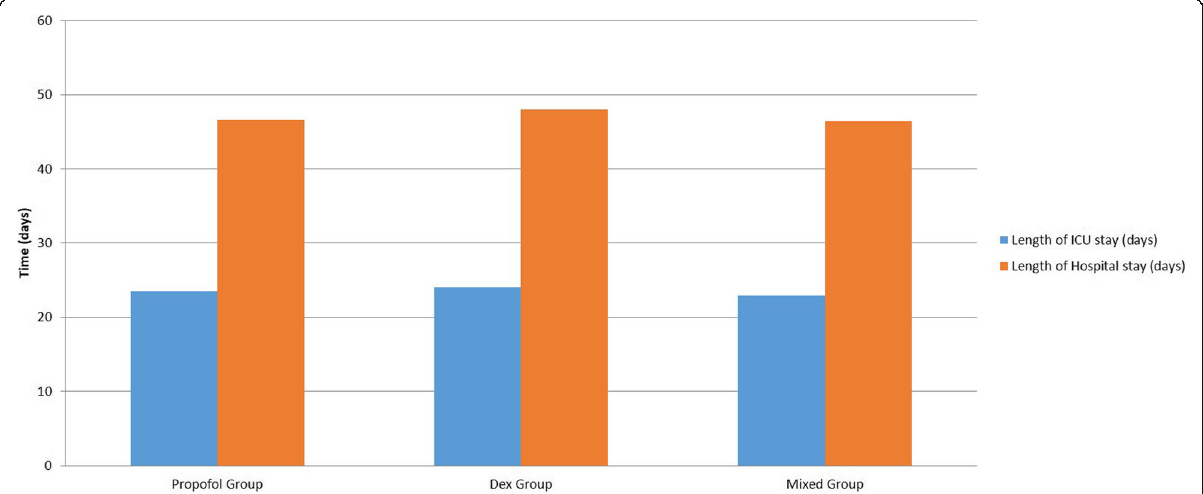
Fig. 8 Length of ICU and hospital stay in the studied groups